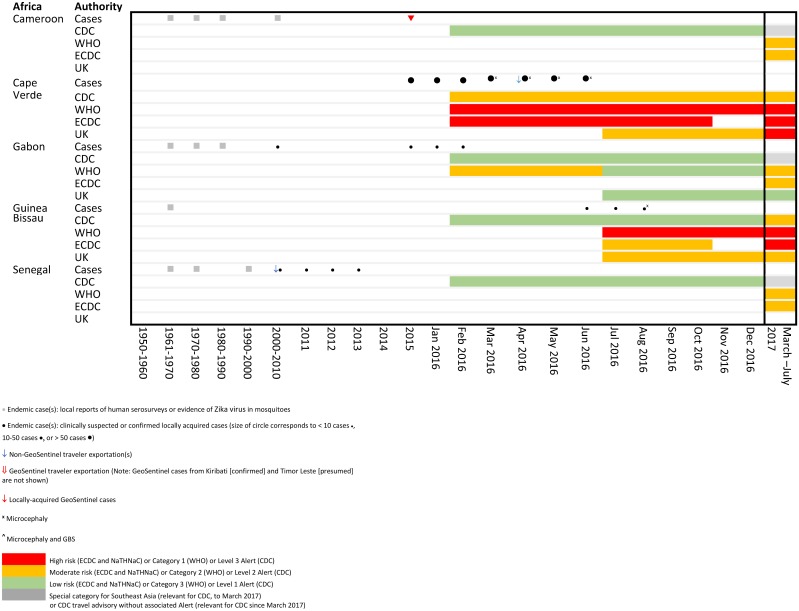
Temporal association of endemic and exported cases with travel notices by international authorities for selected countries in Africa.